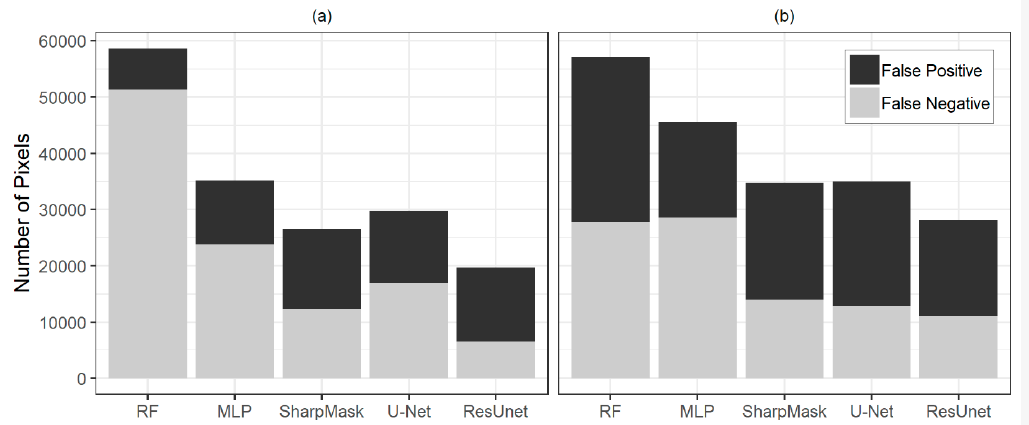
Figure 6. Error distributions in the ( a ) 2017–2018 and ( b ) 2018–2019 time sequences in total pixel Figure6. Errordistributionsinthe( a )2017–2018and( b )2018–2019timesequencesintotalpixelnumbers. numbers.